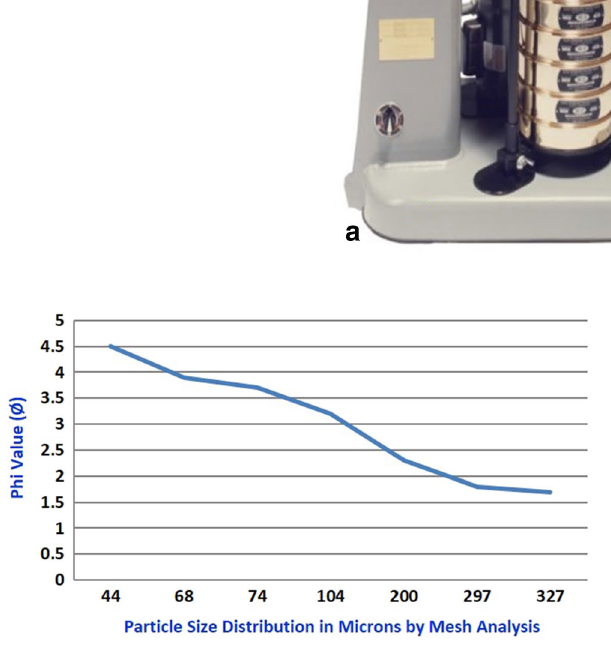
Fig. 2 Different steps involved in the preparation of fibers from groundnut husk in laboratory a raw sample soluble in alkali, b preparation of alkaline solution using NaOH tablets, c oven-dried sample in desiccator Fig. 3 Instruments used while doing direct mesh analysis and their purpose, a sieve shaker instrument used for particle size analysis, b varying mesh sizes used for sample preparation